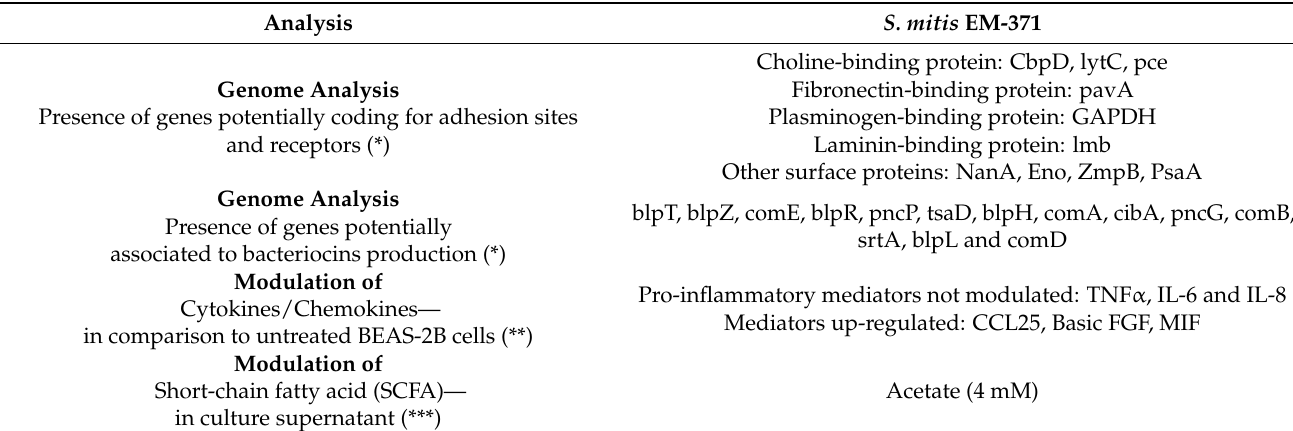
Table 1. Characteristics of S. mitis EM-371 that sustain the potential of this strain as a probiotic. * Data were obtained by whole genome analysis using RAST and PATRIC databases. ** Cytokine and chemokines data are from Mathieu et al., 2020. *** Amount of acetate quantified in the supernatant of an overnight bacterial